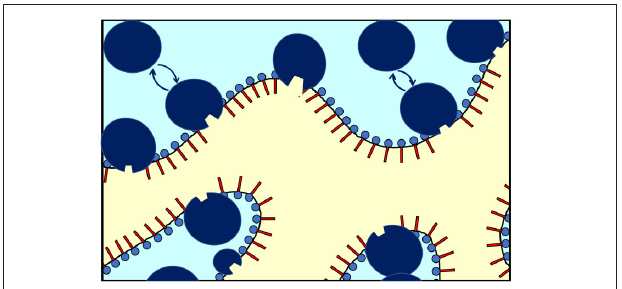
FIGURE 6 | Schematic of the enrichment and exchange of Candida antarctica B (CalB) in the amphiphilic interface of a bicontinuous microemulsion with the surfactant layers and the aqueous phase (light blue) and the oil phase (yellow). The lipase CalB is assumed to reside temporarily at the interface. A fraction of the macromolecules is able to detach and return to the aqueous phase (in light blue). At the same time, the opposite process might take place to some extend (sizes of the surfactant and enzymes are not fully to